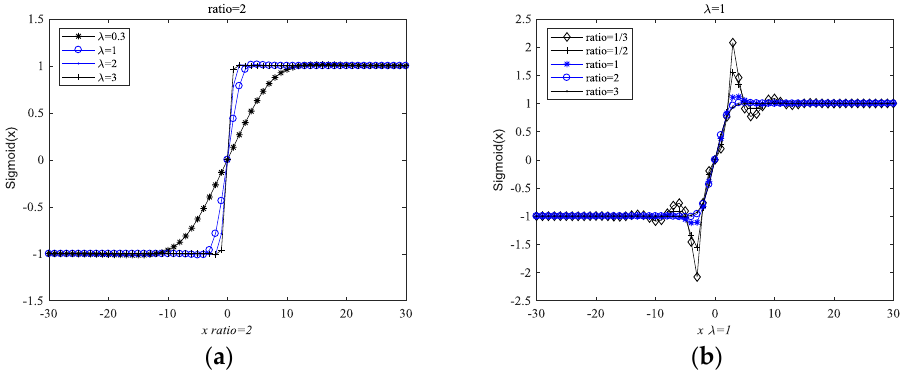
Figure 3. The Sigmoid function curves of the complex signal. ( a ) The Sigmoid function curves of the complex signal with respect to λ ; ( b ) The Sigmoid function curves of the complex signal with respect to the ratio between its real and imaginary components.